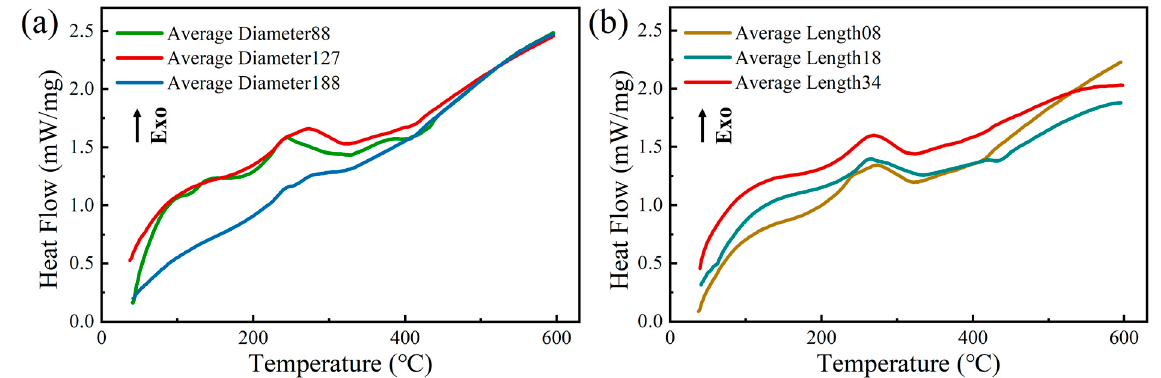
Figure 7. DSC curves of silver nanowire film. ( a ) Silver nanowire films prepared with silver nanowires (1), (2), and (3) in Figure 1. ( b ) Silver nanowire films prepared with silver nanowires (2), (4), and (5) in Figure 1.